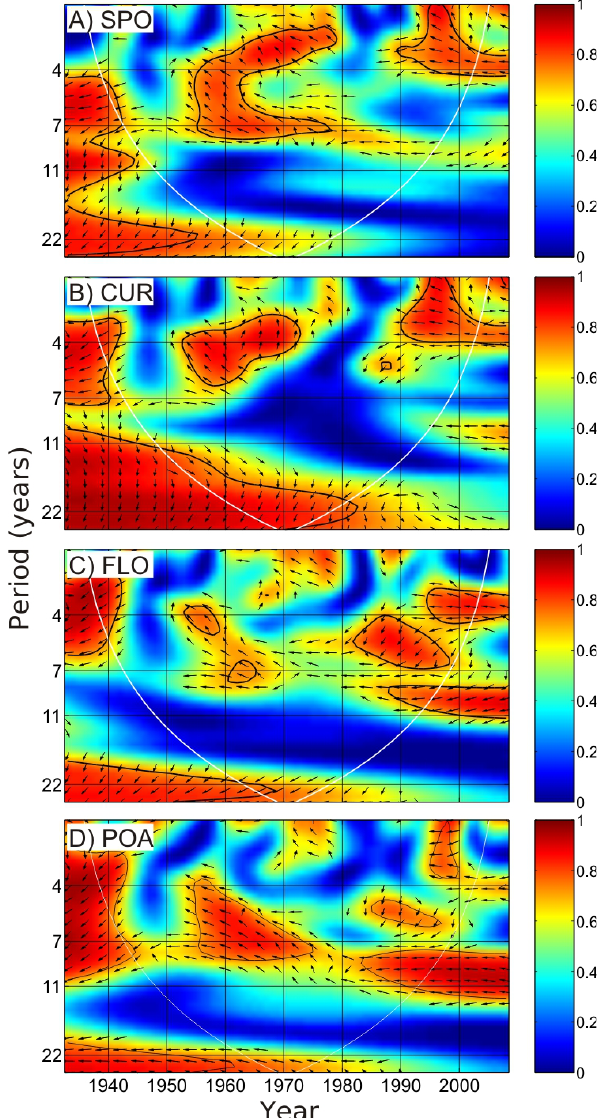
Fig. 7. Similar to Fig. 5, but considered for the wavelet coherence spectrum between the temperature data and the SOI index time se- ries computed for SPO (A) , CUR (B) , FLO (C), and POA (D)